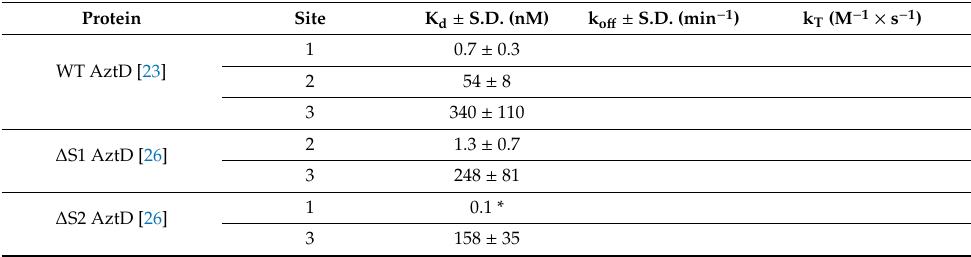
Table 1. Zinc binding a ffi nity and stoichiometry of WT and mutant